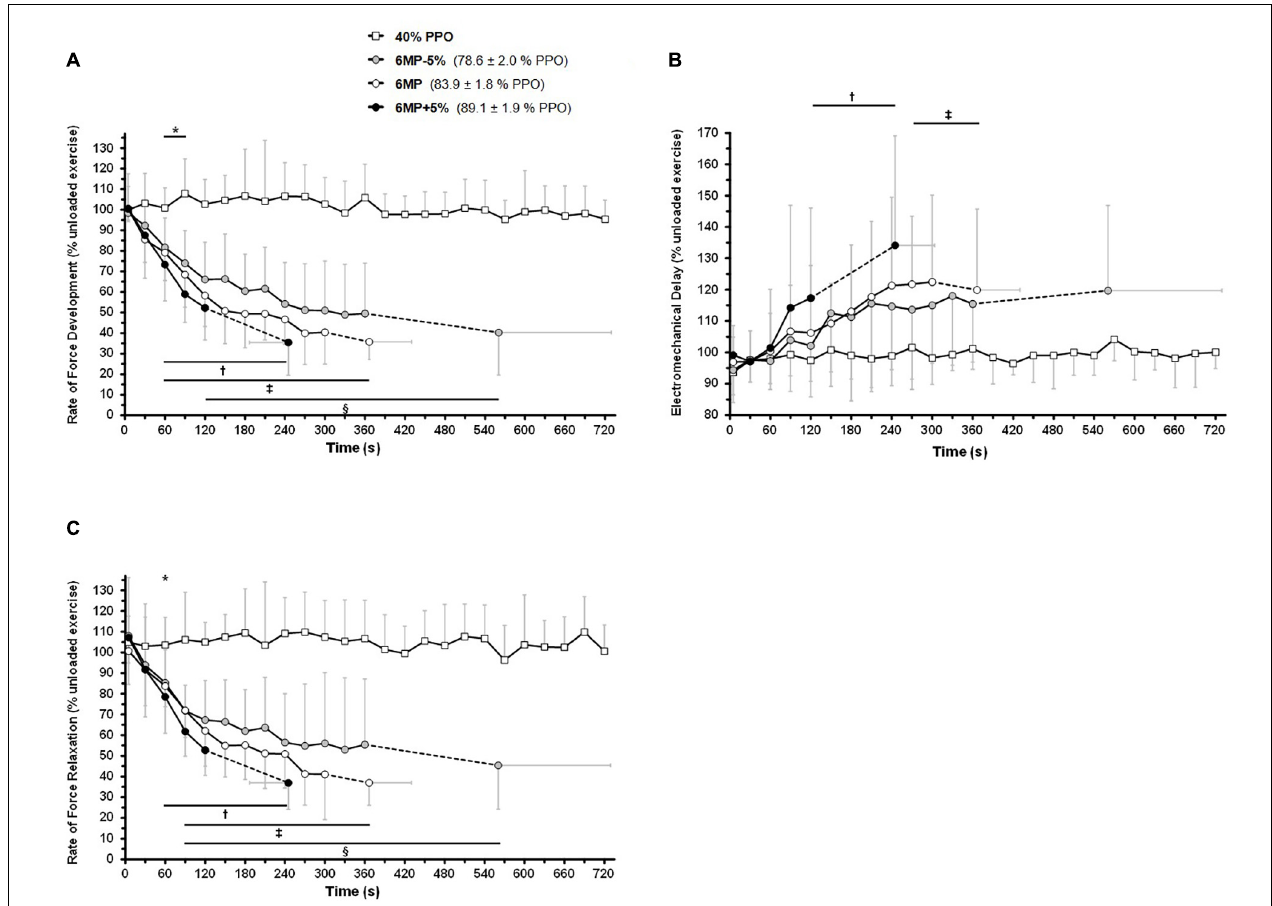
FIGURE 3 | Intensity-dependent effects of dynamic exercise on the rate of force development, relaxation, and electromechanical delay. The participants ( n = 11) completed 12 min of non-exhaustive, one-legged knee-extension exercise at 40% of peak power output (40% peak power output, PPO) as well as three exhaustive exercise trials at the maximal mean power sustainable for 6 min (6MP) as well as at intensities 5% below (6MP-5%) and above (6MP+5%). M. quadriceps twitches were elicited by a 100-Hz double stimulation delivered in the passive knee-flexion phase at 5 s and subsequently every 30 s of exercise. The first derivative of the force signal was computed to calculate the maximum contraction (A) and relaxation (C) rates (rate of force development, rate of force relaxation; see section “Materials and Methods”). (B) Electromechanical delay. The results are mean ± SD. The data were analyzed taking into account all time points using a repeated-measures linear mixed model, followed by Holm–Sidak corrected post hoc test. * 40% PPO is significantly different from 6MP-5% and 6MP at the same time point (intensity effect, P < 0.05). † 6MP+5%; ‡ 6MP; and § 6MP-5% differ significantly from the first time point (5 s) at the same intensity (time effect, P < 0.05) and from 40% PPO at the same time point (intensity effect, P <